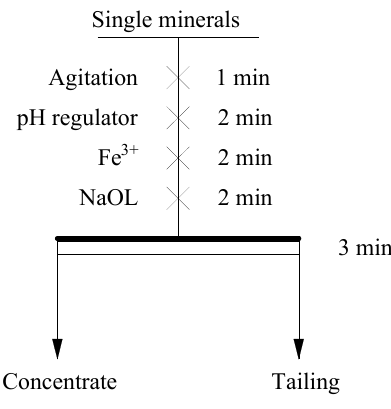
Figure 2. Flowsheet of single mineral flotation tests.